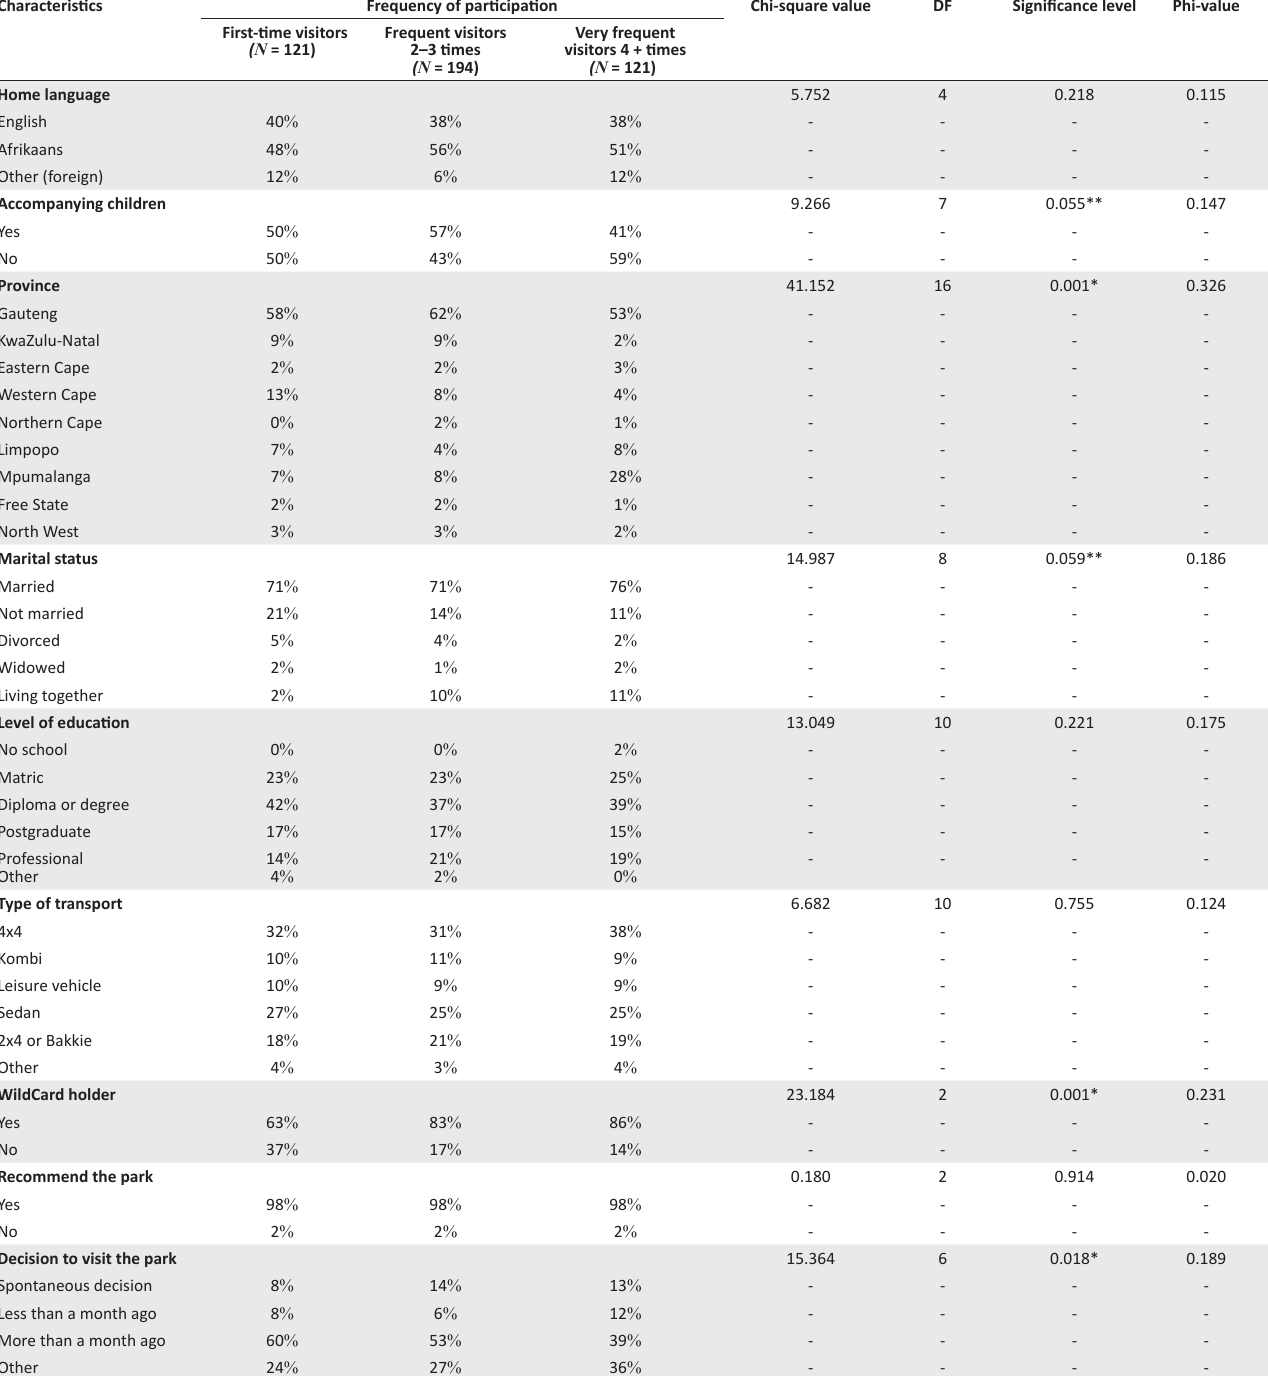
TABLE 5: Chi-square test results of visitor characteristics of first-time and repeat Kruger National Park visitors.